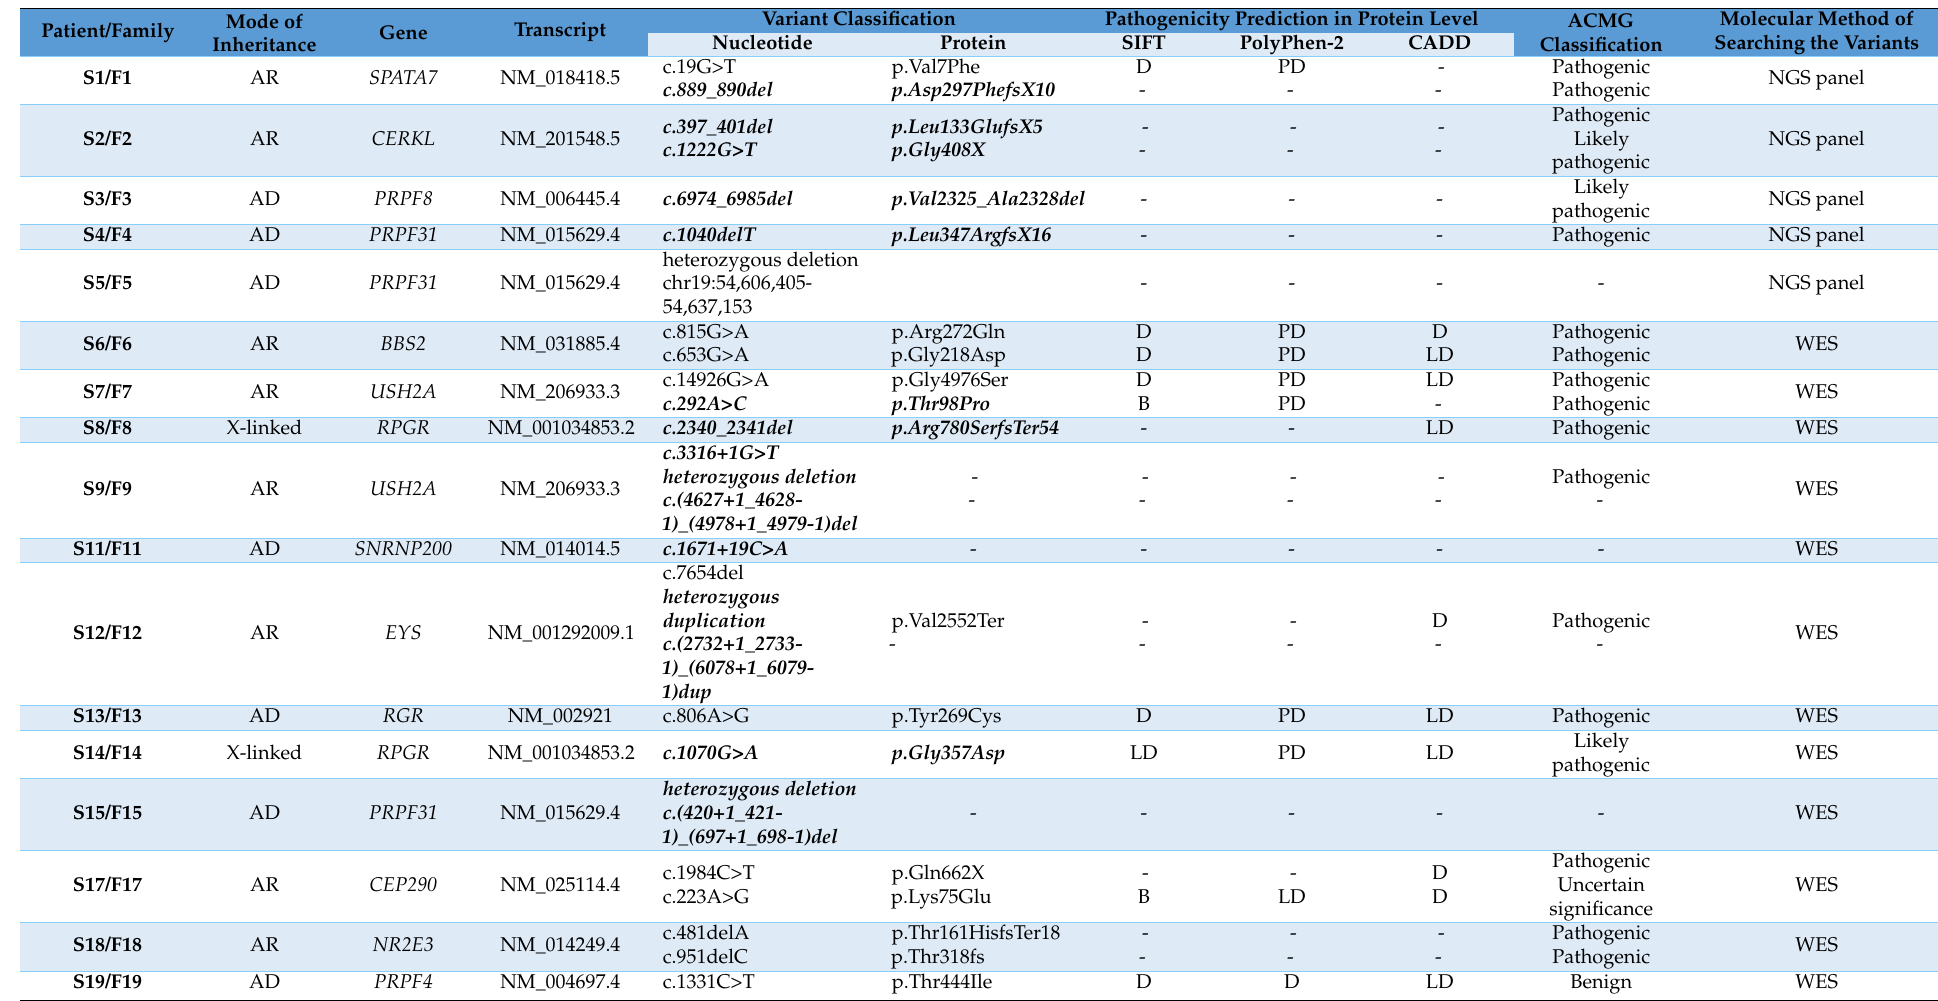
Table 2. Pathogenic DNA variants identified in RP